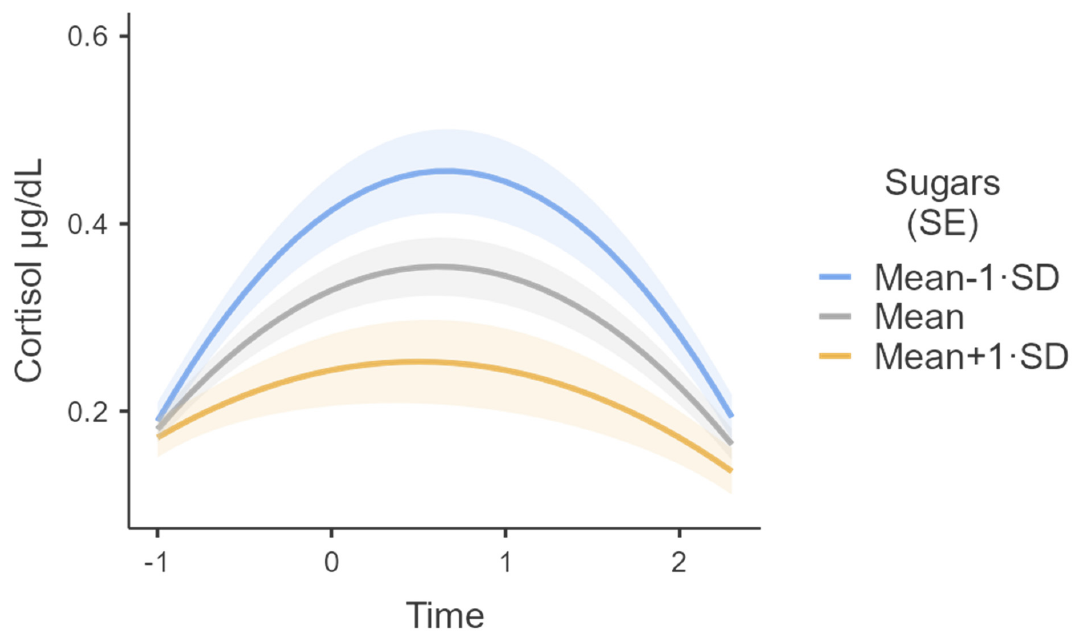
Figure 2. Variability in cortisol response ( µ g/dL) over time for High (+1 SD), Mean and Low ( − 1 SD) levels of sugar consumption. Semi-transparent areas indicate Standard Errors. Time was coded as − 1, 0, 0.75, and 2.25 following the original four points of measurements of baseline and 20, 35, and 65 min after the CPT.